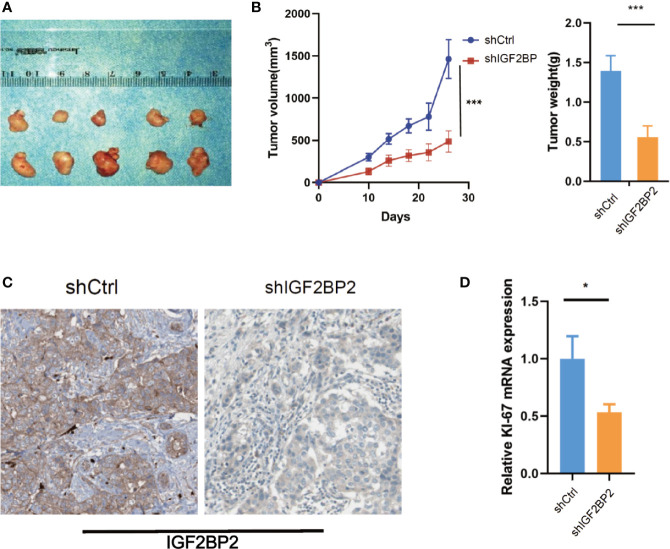
IGF2BP2 Promotes HCC Cells Tumorigenicity in vivo. (A, B) Knockdown of IGF2BP2 effectively inhibited HepG2 cells subcutaneous tumor growth in nude mice (***P < 0.001, Student’s t-test). (C) IHC analysis of IGF2BP2 in tumor tissue samples. (D) qRT-PCR analysis of KI-67 in tumor samples. (*P <0.05, Student’s t-test).